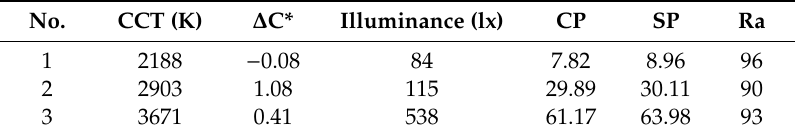
Table 3. Three museums of 3 spectral properties. (No.1 is the national museum of western art. No.2